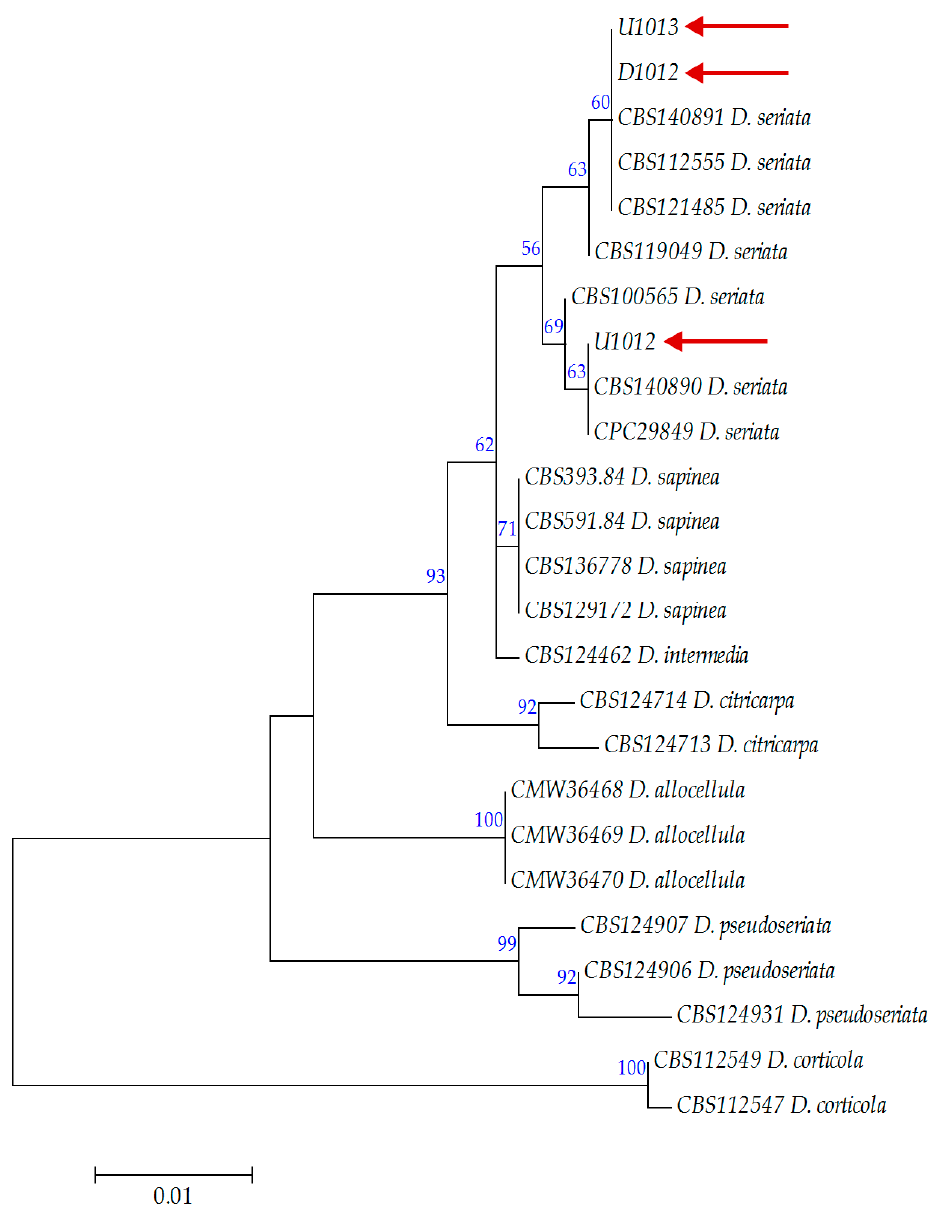
Figure 6. Maximum likelihood phylogeny inferred for the Diplodia seriata species complex for the concatenated ITS and tef1 molecular taxonomy markers. The publicly accessible sequences of the analyzed strains from previous studies are in Supplementary Table S1 and those from this study in Table 2. The names of three monoclonal isolates cultured from walnut tree materials (this work) are indicated in red. Strain CBS 112555 is a culture of the epitype Diplodia seriata . Branch length is proportional to the number of nucleotide changes per site; the scale bar is shown underneath the tree. Relative bootstrap values resulting from 1000 iterative replicates are given beside the relevant nodes, where they exceed 50%. The tree is rooted on Diplodia corticola A.J.L. Phillips, A. Alves, and J. Luque (strains CBS 112549 and CBS 112547) orthologous sequences,